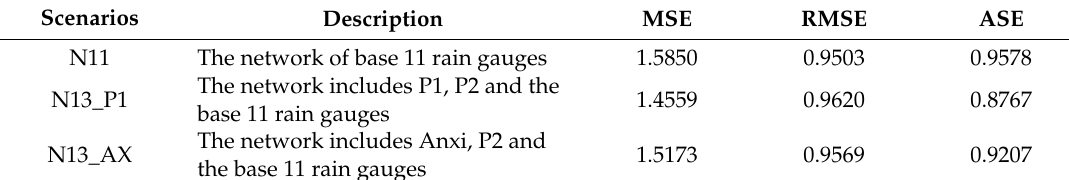
Table 3. Cross-validation statistics of the base rain gauge network and its optimal network.